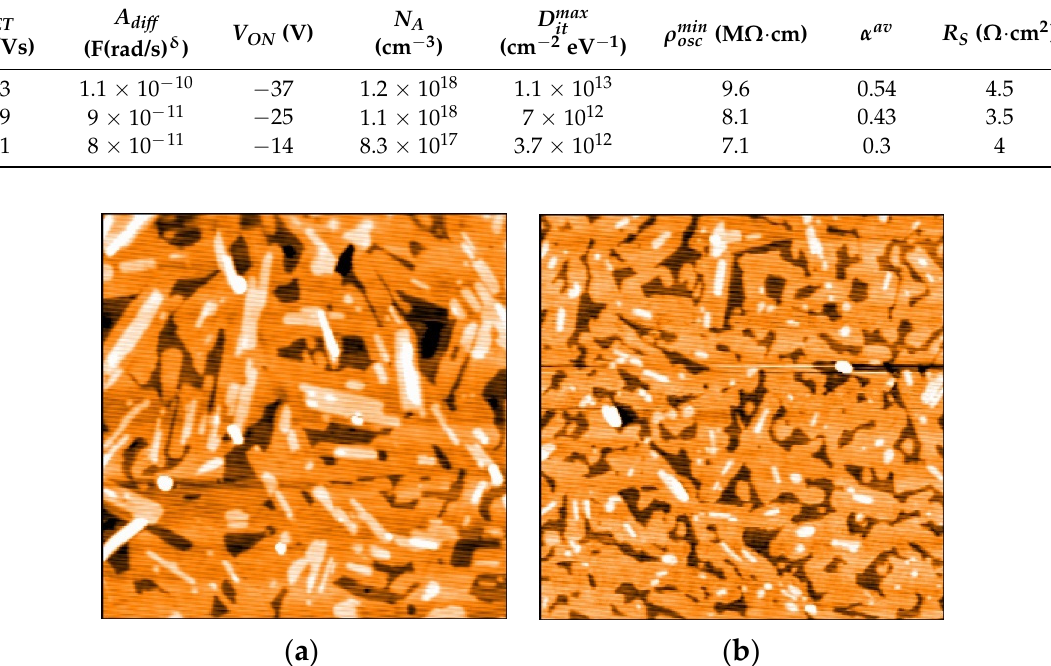
Figure 5. AFM images (5 µ m × 5 µ m) of OSC film deposited at RT ( a ) on SiO 2 and ( b ) on SiO 2 /HMDS.